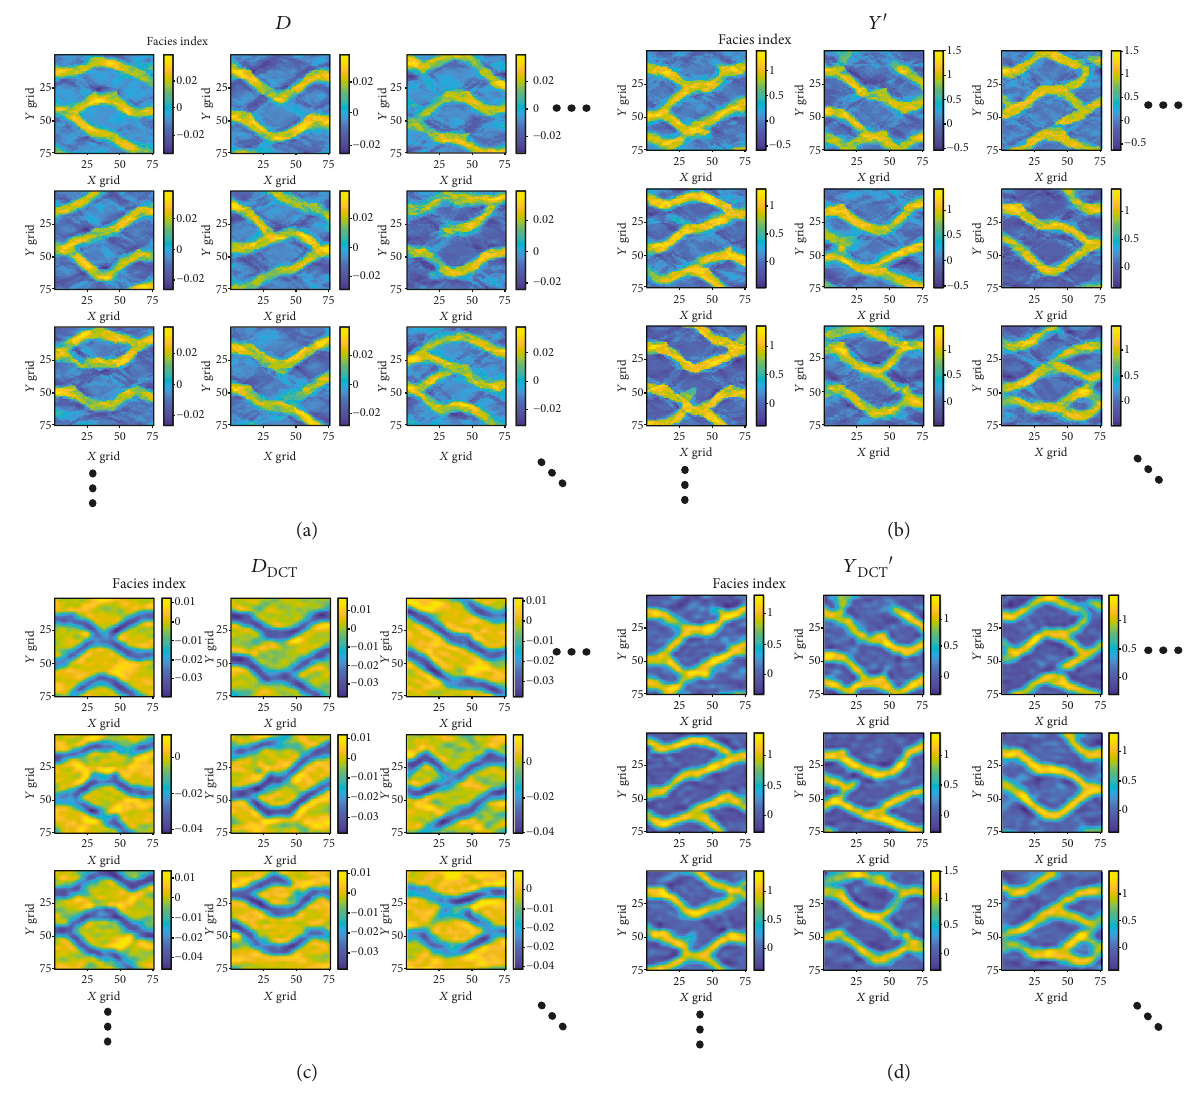
Figure 8: Reservoir realizations of dictionaries and reconstructed libraries from Figure 7. (a, b) D and Y ′ of Figure 7(d), respectively. ′ of Figure 7(f), and Y (c, d) D DCT DCT Table 1: Comparison of state vectors and postprocesses after each assimilation for ten ES-MDA algorithms investigated in this study. State vector m Postprocess after every assimilation